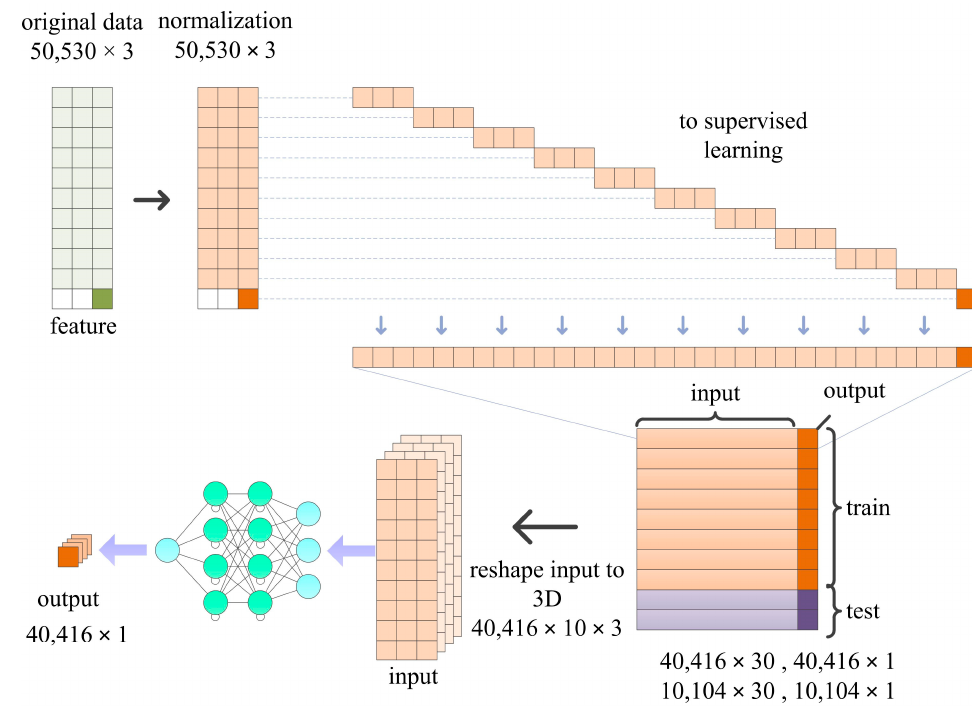
Figure 4. Schematic diagram of data processing flow of supervised learning